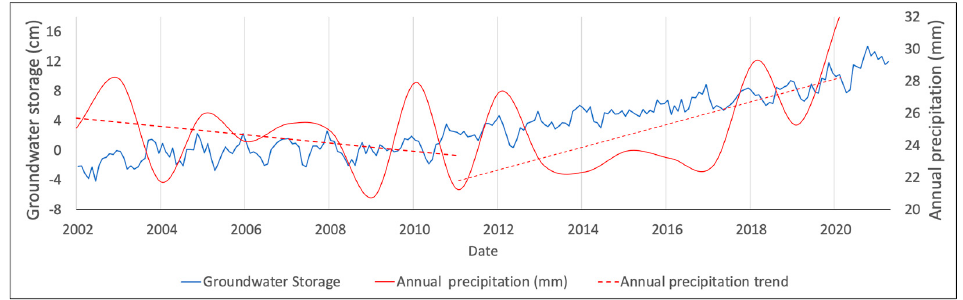
Figure 14. Groundwater storage (cm) and observed average annual precipitation (mm) of the Iullemeden basin.